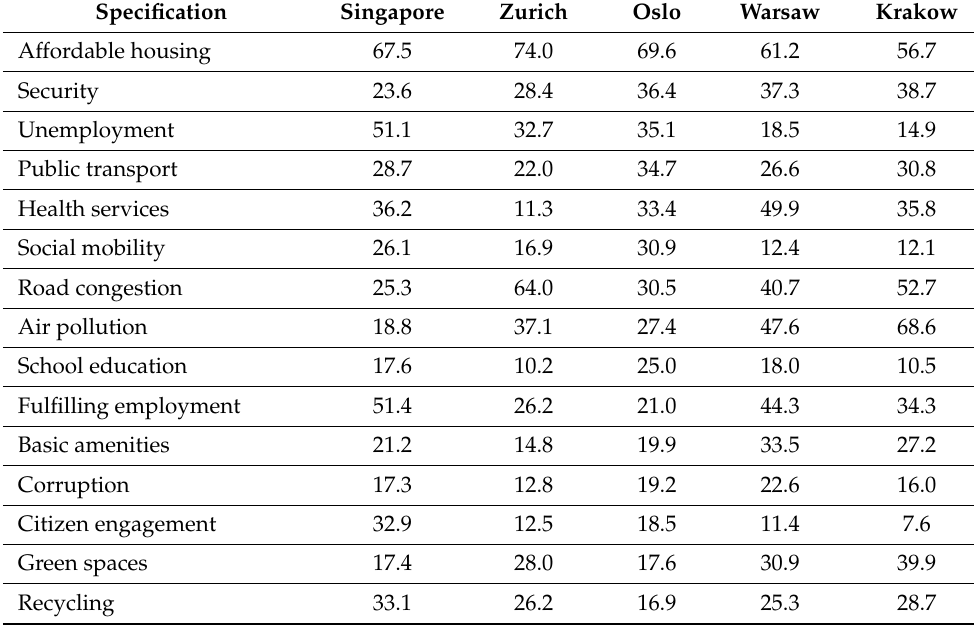
Table 5. A cumulative list of smart city scoring on the basis of the IMD-SUTD Smart City Index (SCI)—priority areas according to inhabitants [%]